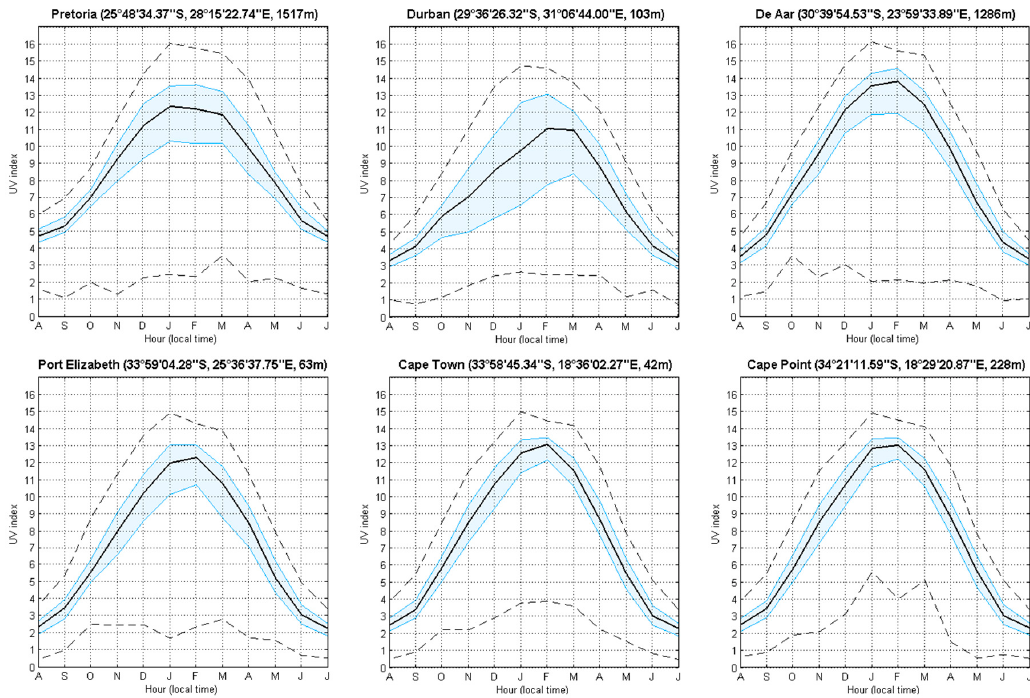
Figure 6. Monthly climatological median (black line) of solar UVI for the six South African sites at satellite overpass time, for all years of observation (i.e., 1994–2015). Quantile 25 and 75 (filled blue lines) and minimum and maximum (black dash line) are also represented.